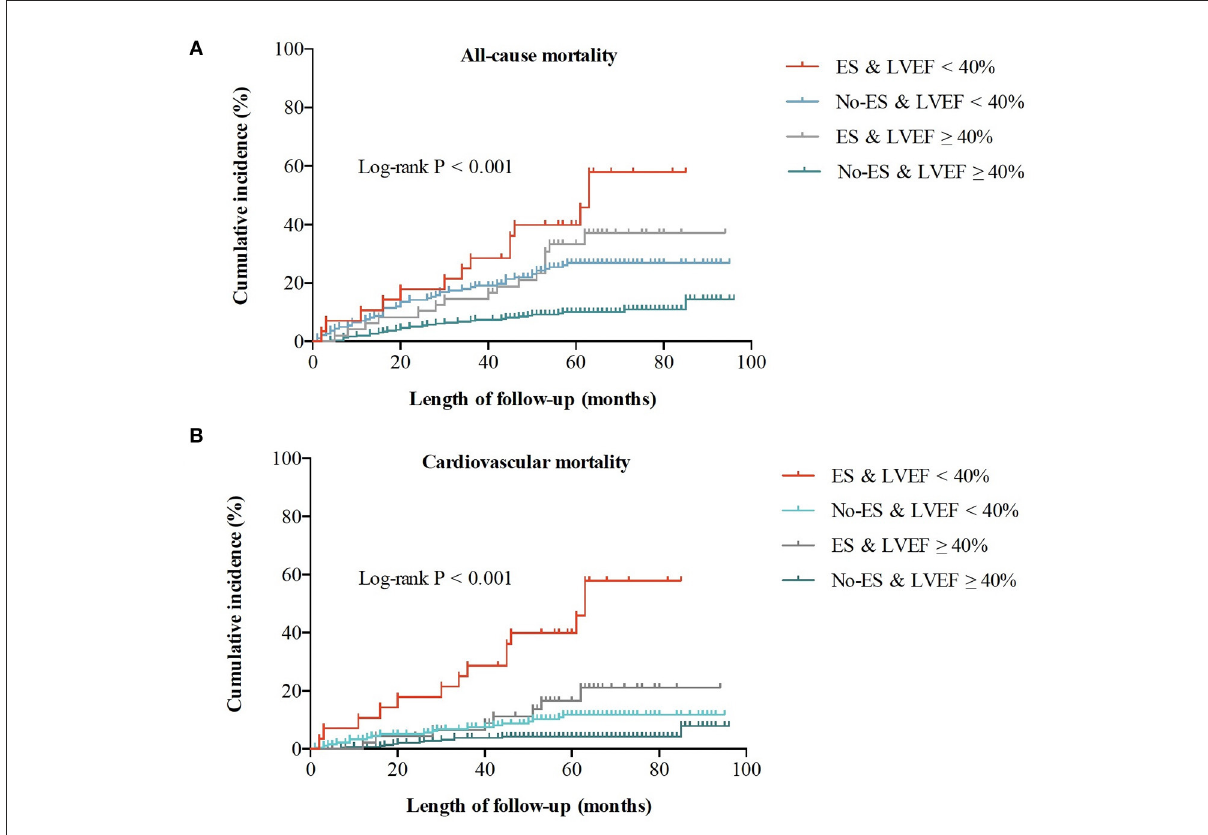
FIGURE2 Cumulative incidences of all-cause and cardiovascular mortality for the whole population. (A) All-cause mortality for 4 groups. (B) Cardiovascular mortality for 4 groups.